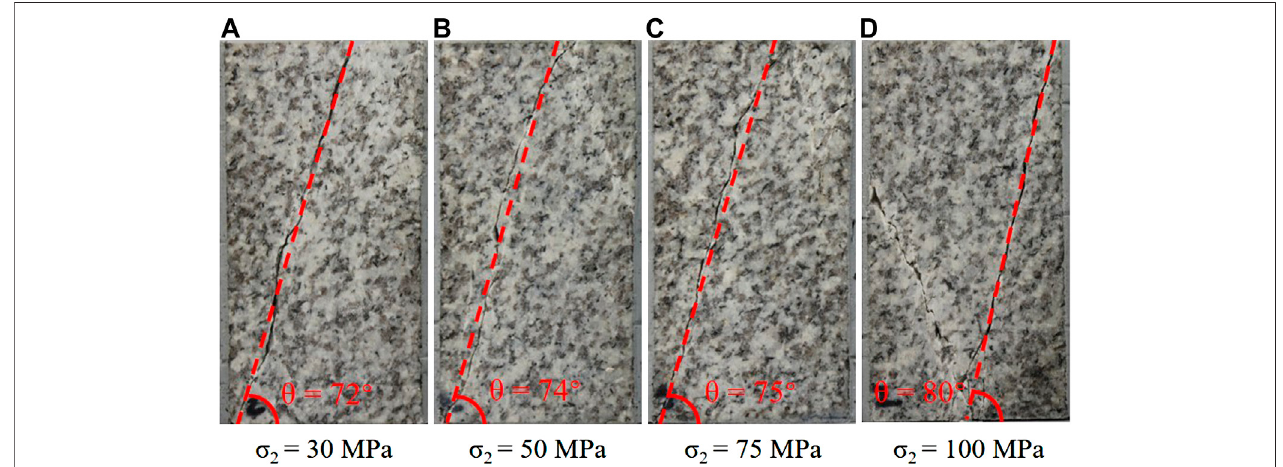
FIGURE 11 | Fracture angle and failure mode of granite samples adopted in the true triaxial experiment (revised form Zhang 2020).